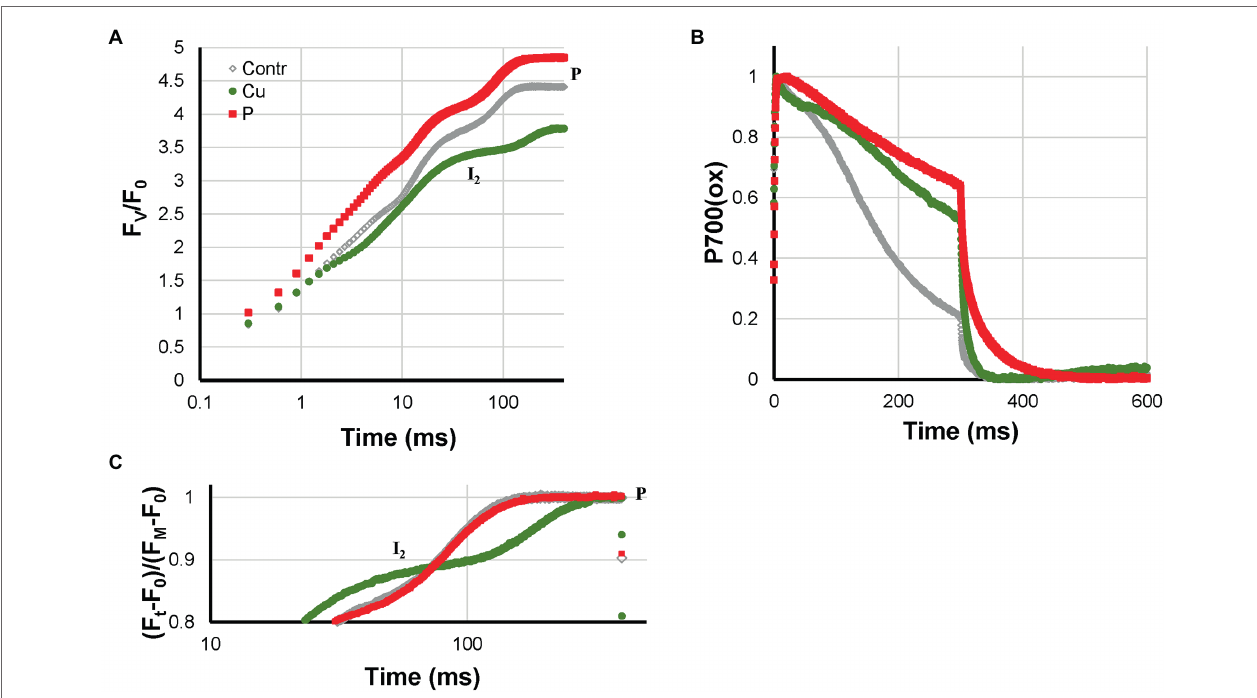
FIGURE 2 | Effect of P- and Cu-deficiencies applied to hydroponically grown sunflower plants on the polyphasic rise (A) and P700 + kinetics (B) , respectively. In panel (C) , the double-normalized I 2 -P amplitudes are shown to allow a comparison of the rise kinetics. The transients are averages of four independent